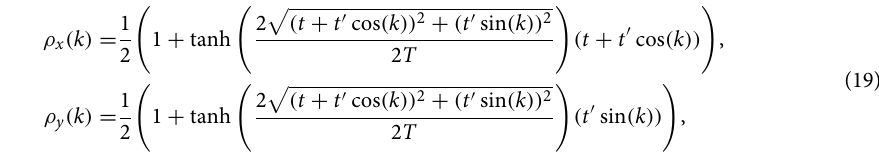
whose integral over the closed interval gives the WN. For the non-Hermitian case, WN is calculated as the average of individual WNs around the exceptional points 75 , i.e., W